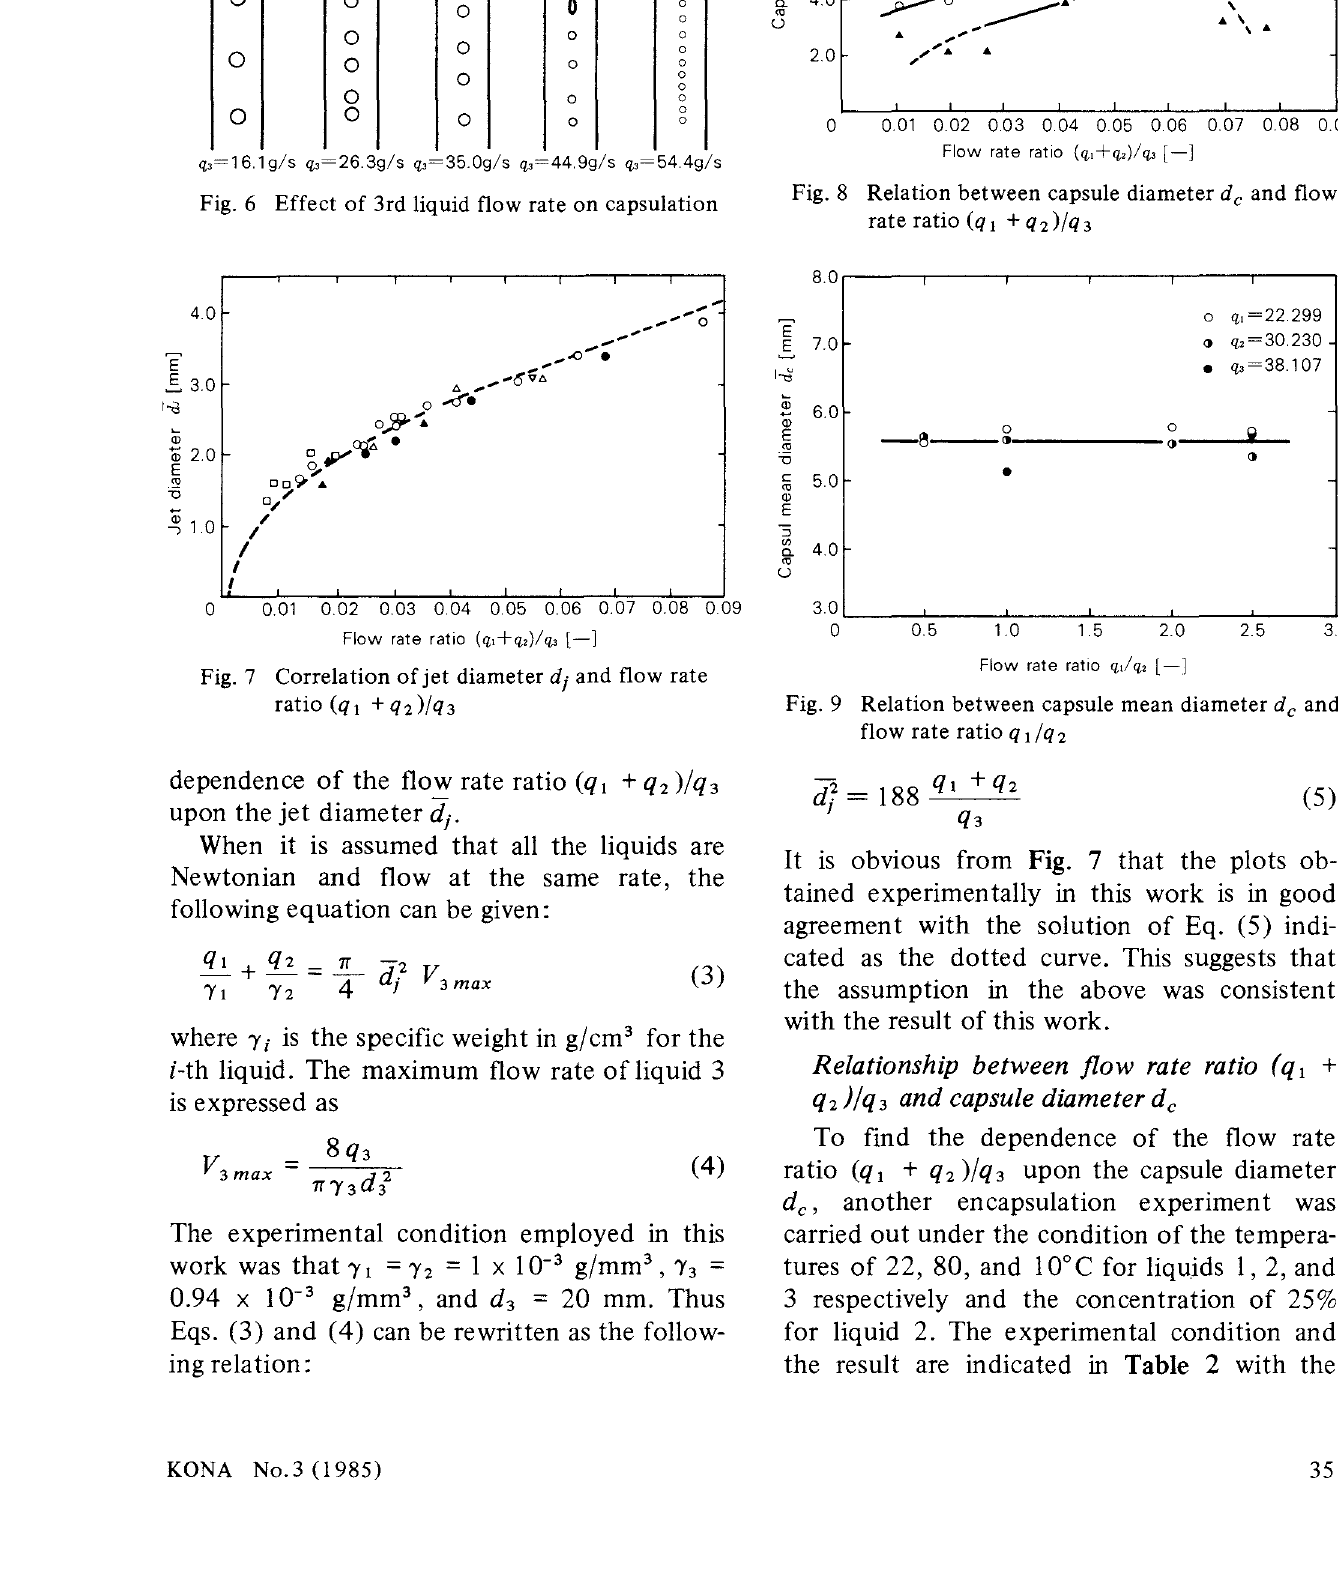
Fig. 8 Relation between capsule diameter de and flow